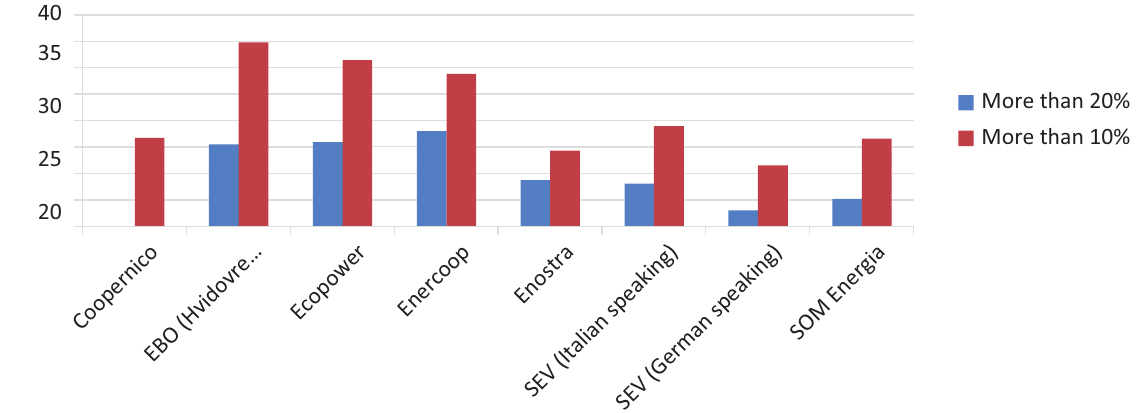
Figure 5. Reporting of more than 10% and 20% energy savings realised, in % of respondents, by REScoop (2018 survey).